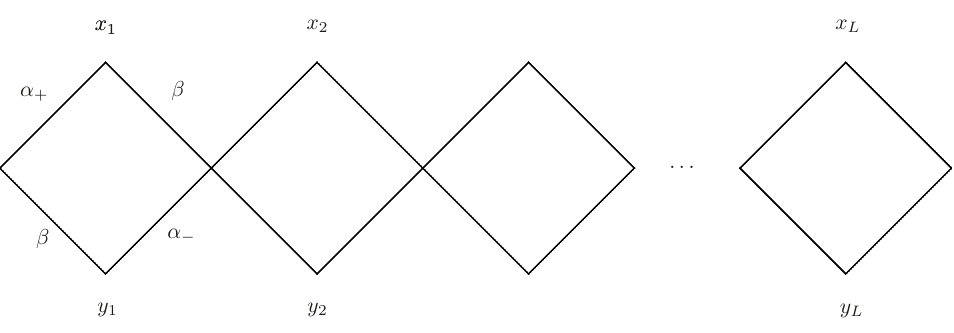
Figure 6 . Diagrammatic representation of the transfer matrix (2.22). It is obtained by gluing together J rectangles, each representing the R (cid:0) operator. The leftmost and rightmost vertices are identi(cid:12)ed. The values of indices (cid:11) (cid:6) and (cid:12) are the same as in (cid:12)gure